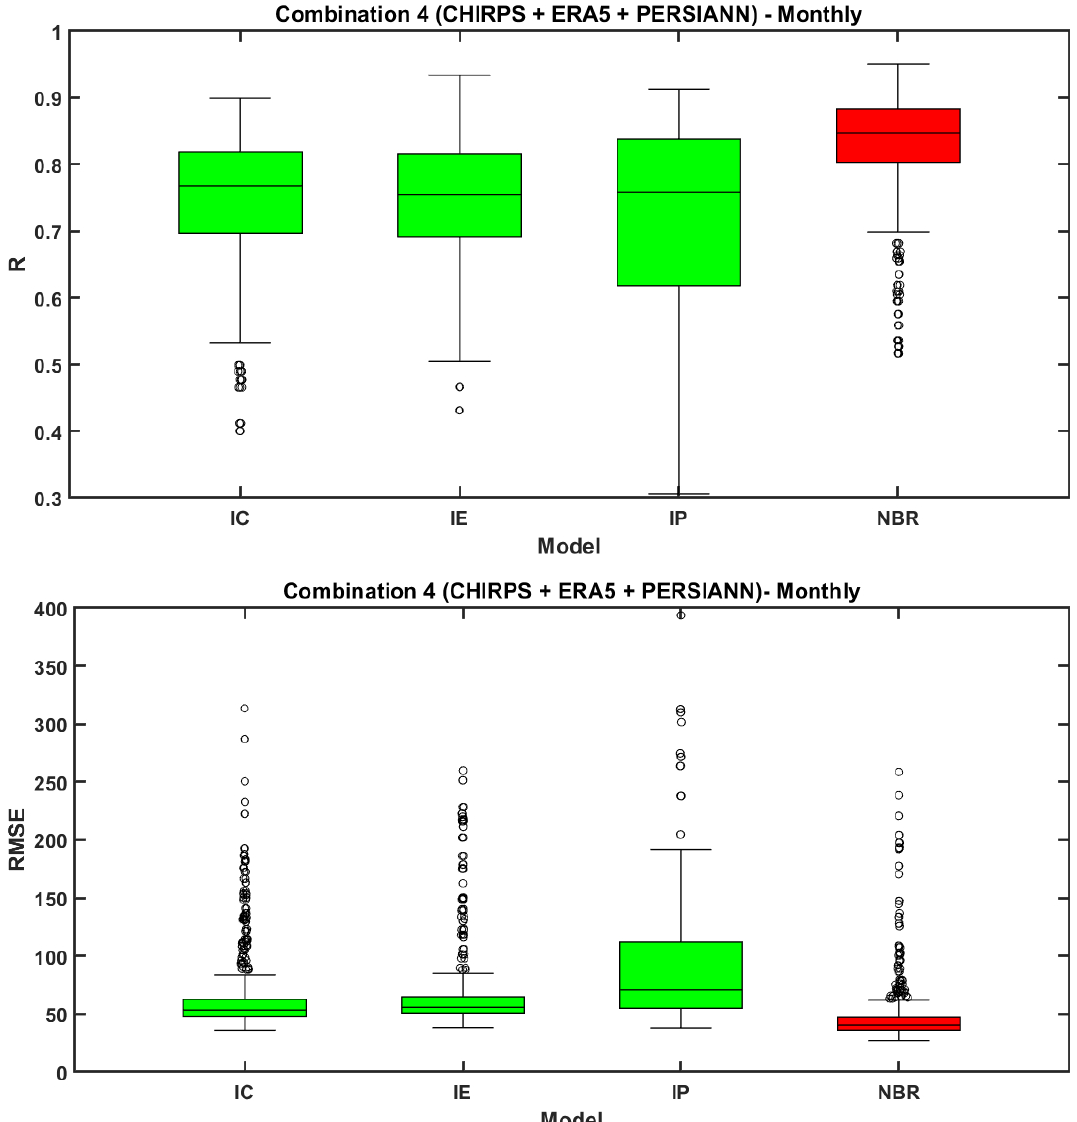
Figure 7. Boxplots representing the performance of individual and integrated precipitation dataset (NBR) under combination 4 in terms of R and RMSE at 3-day and monthly time steps.